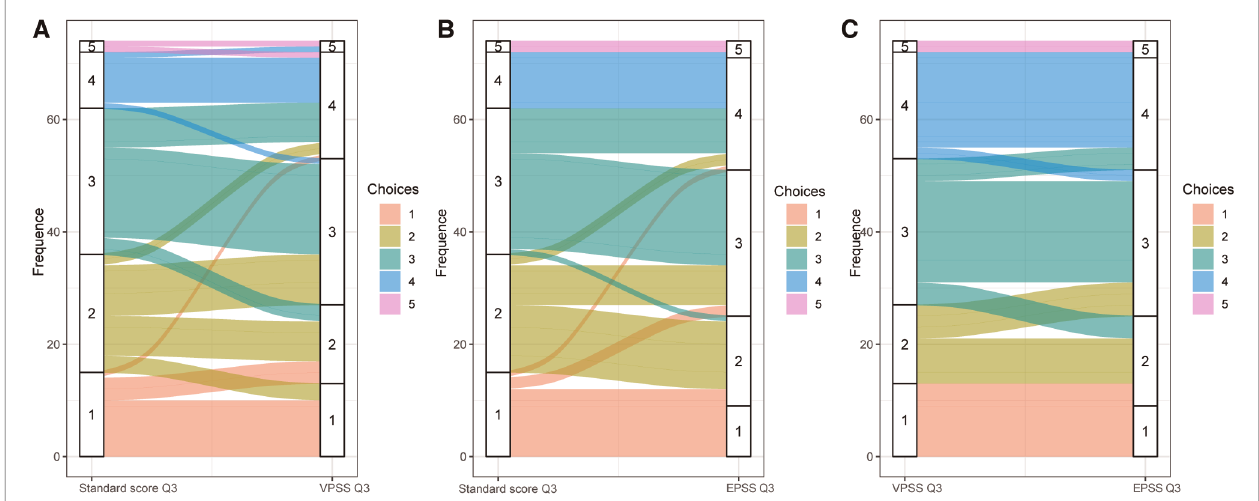
FIGURE 4 | The Sankey diagram showing the different choice patients made of question 3 in ( A ) RS and VPSS, ( B ) RS and EPSS from doctors, and ( C ) VPSS and EPSS. Choices No. 1 to No. 5 represent normal, weak stream, slim stream, interruption urination, and dripping. The fl ow of colors re fl ects the different choices patients made in VPSS, EPSS, and RS, representing the patients changed their mind with different scales. The width of fl ow represents the amount. Both VPSS and EPSS revealed more “ urinary interruption ” situations (the No. 4 choice) than doctors. The fl ow in ( A ) is obviously more chaotic and wider than the fl ow in ( B ), indicating a prominent advantage of EPSS in question 3. In ( C ), fl ows of VPSS ended in separated EPSS choices. It shows that EPSS differentiates the “ normal ” (No. 1 choice) and “ weak stream ” (No. 2 choice) conditions better than VPSS.